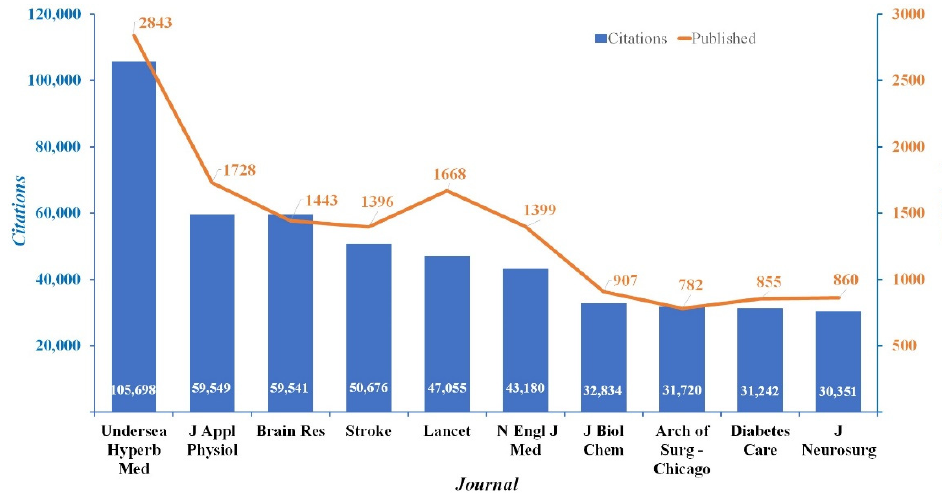
Figure 7. Overlay visualization of the journals.